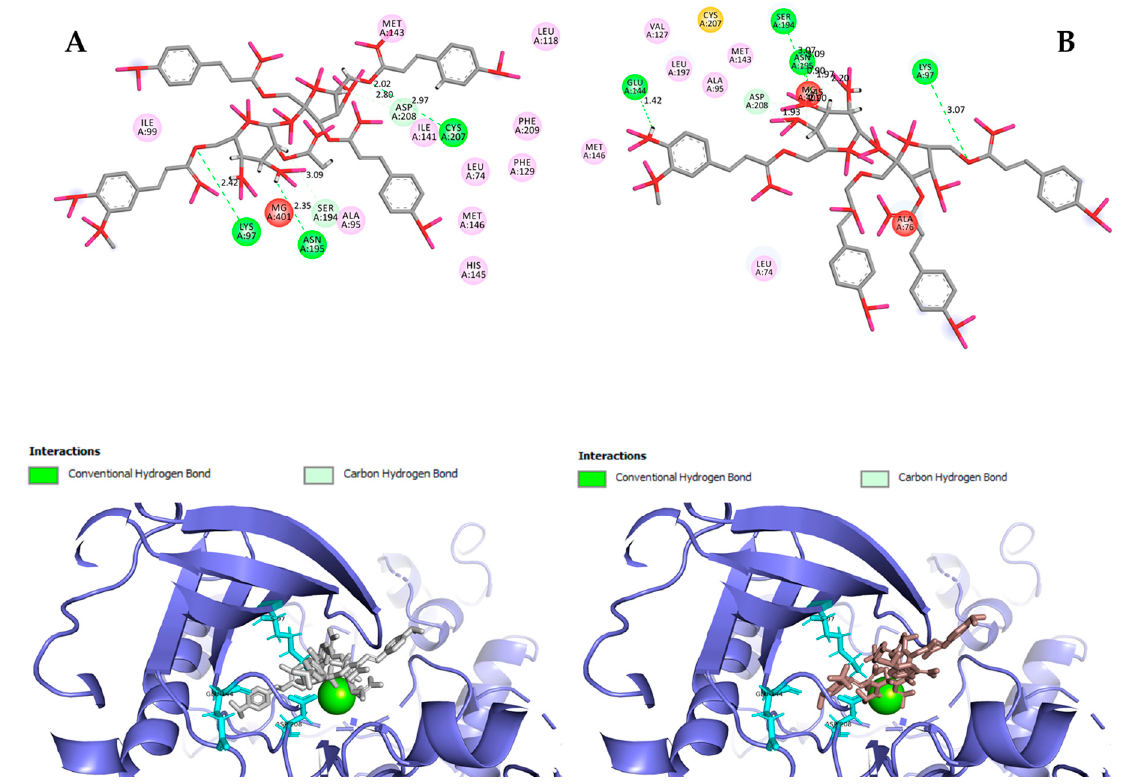
Figure 8. 2D and 3D interactions of vanicoside A ( A ) and vanicoside B ( B ) with the MEK-1 kinase.